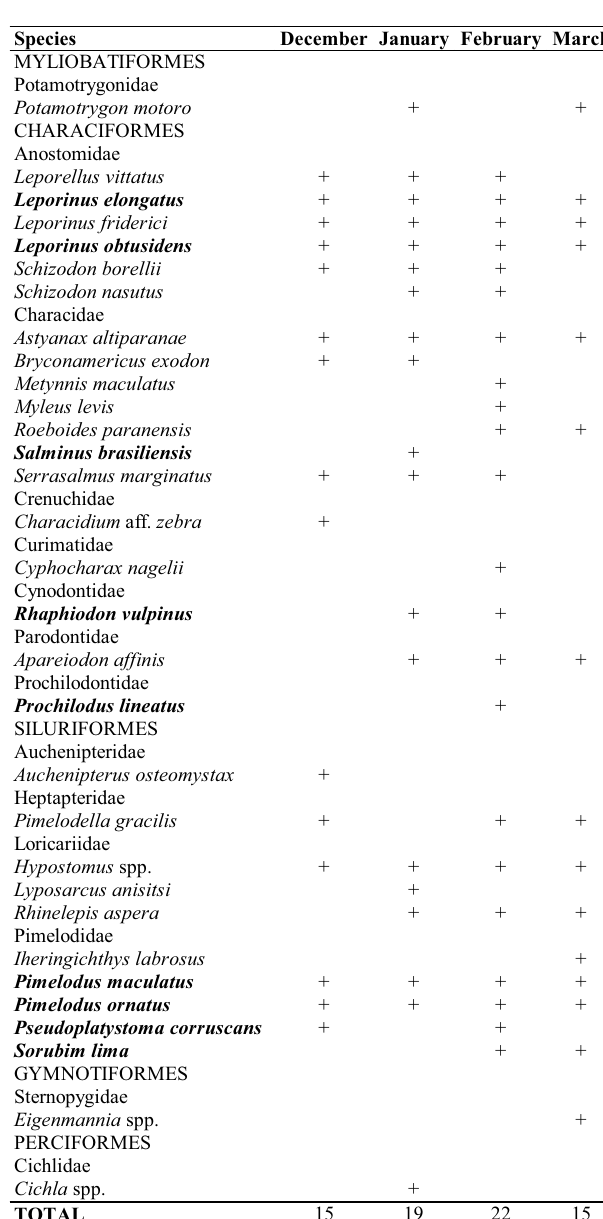
Table 1. Species sampled in Protocol I conducted at the fish ladder of Engenheiro Sergio Motta Dam, during the period of December, 2004 to March, 2005. Migratory species are in